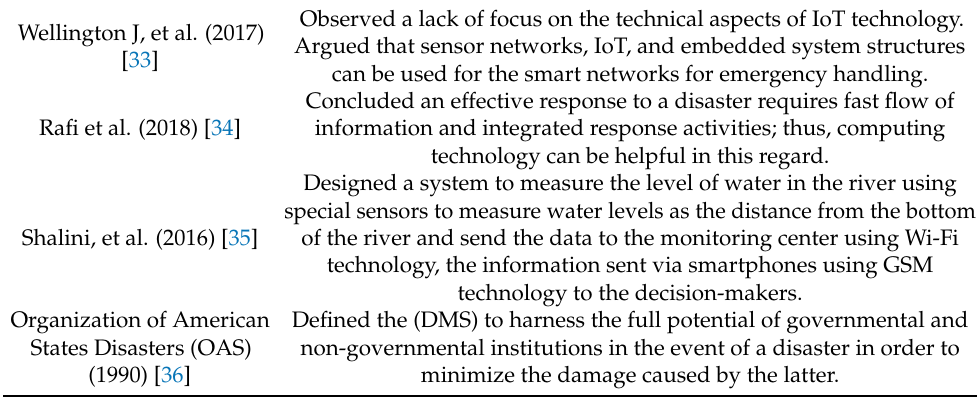
Table 1. Recent studies with their